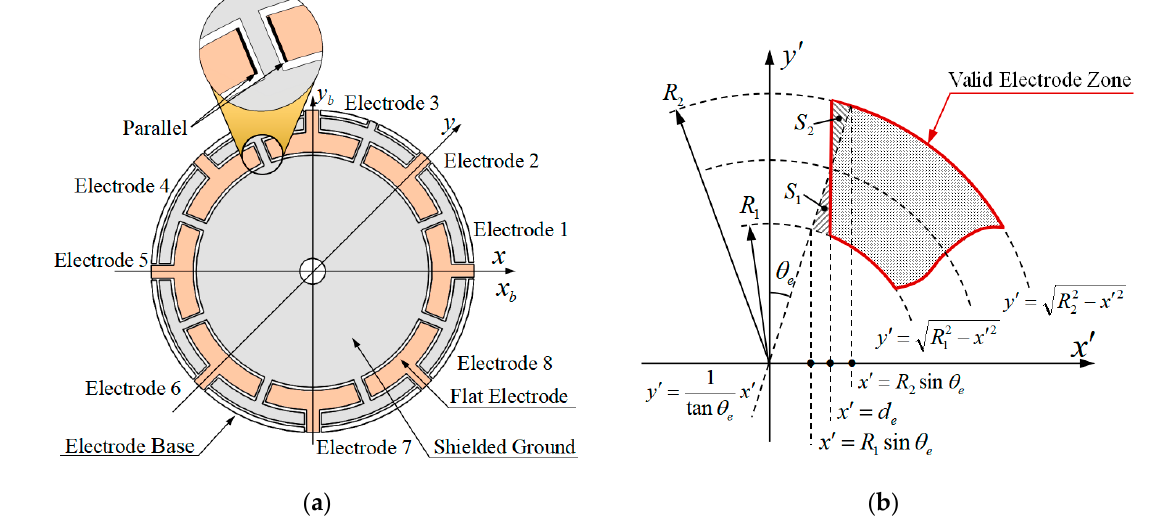
Figure 8. Electrode of flat-electrode HRG: ( a ) Top view of electrode base; and, ( b ) Enlarged view of part Valid Electrode Zone.